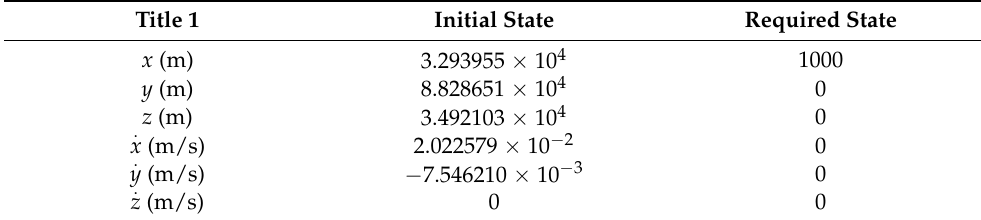
Table 2. Initial and required states in the orbital frame.